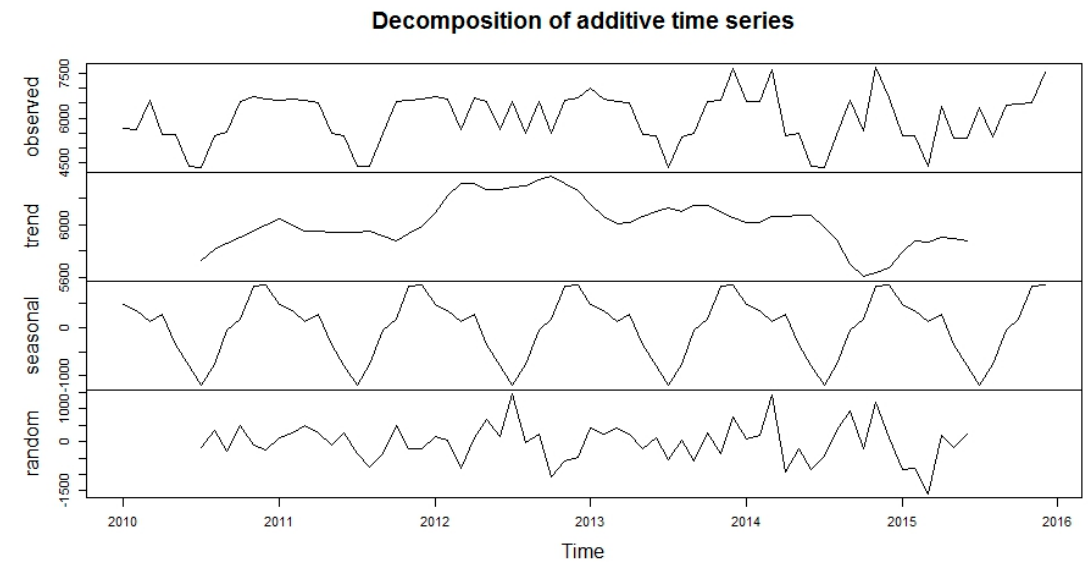
Figure 3. Additive decomposition of monthly time series cases of TB prevalence data.